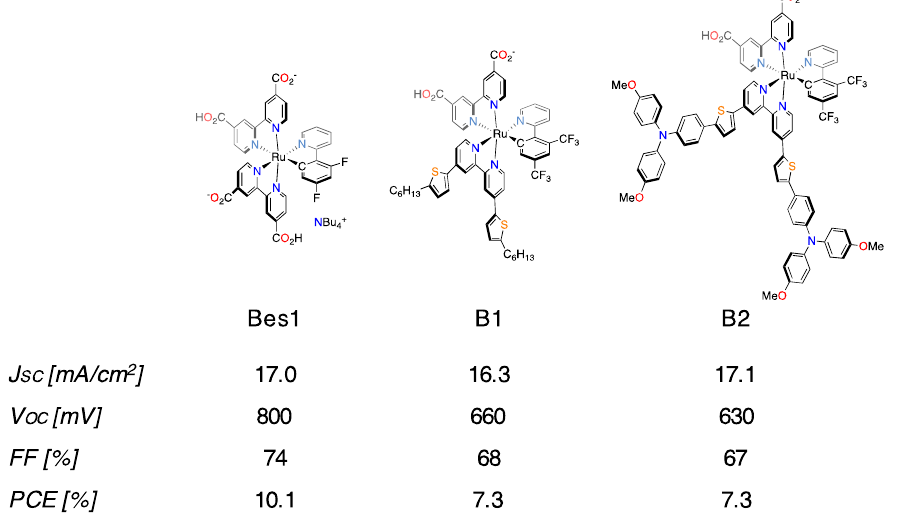
Figure 12. The photovoltaic performance of Bes1, B1, and B2 tris -heteroleptic cyclometalated ruthenium complexes. For Bes1 solar cells with transparent and scattering titania films of 12 and 3 μm thicknesses were manufactured [111]. B1 and B2 were reported in separated articles and highest efficiencies for both of them were achieved with the same electrolyte composition and with transparent and scattering titania films of 12 and 3 μm thicknesses [116,117] .